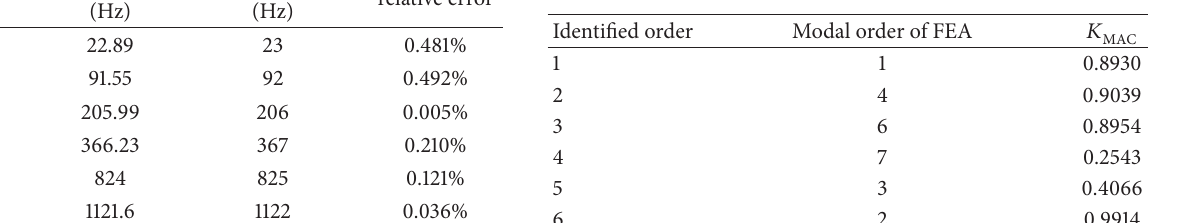
Table 12: The identified order and MAC value of modal